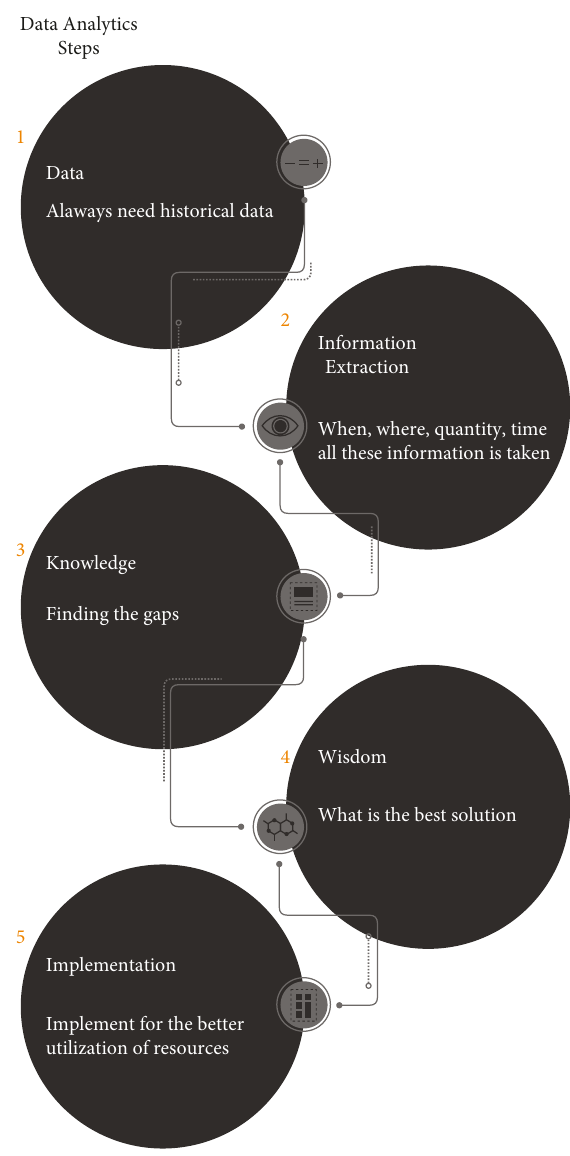
Figure 3: Data analytics